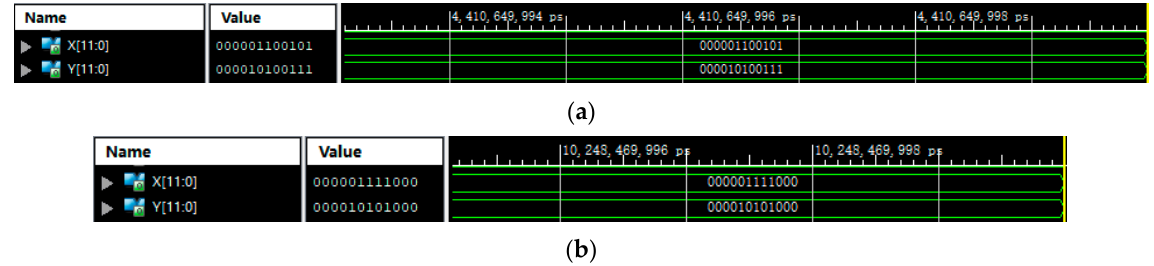
Figure 13. Simulation results of centroid coordinates. ( a ) Left spot centroid coordinates. ( b ) Right spot centroid